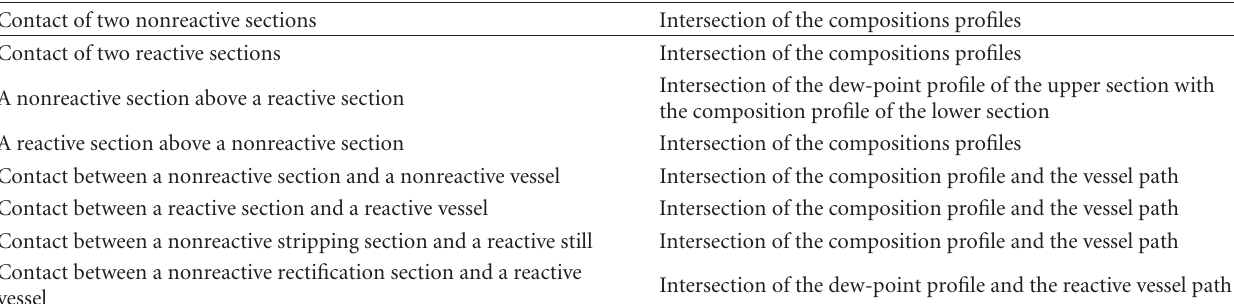
Table 3: Conditions of feasibility at column section junctions